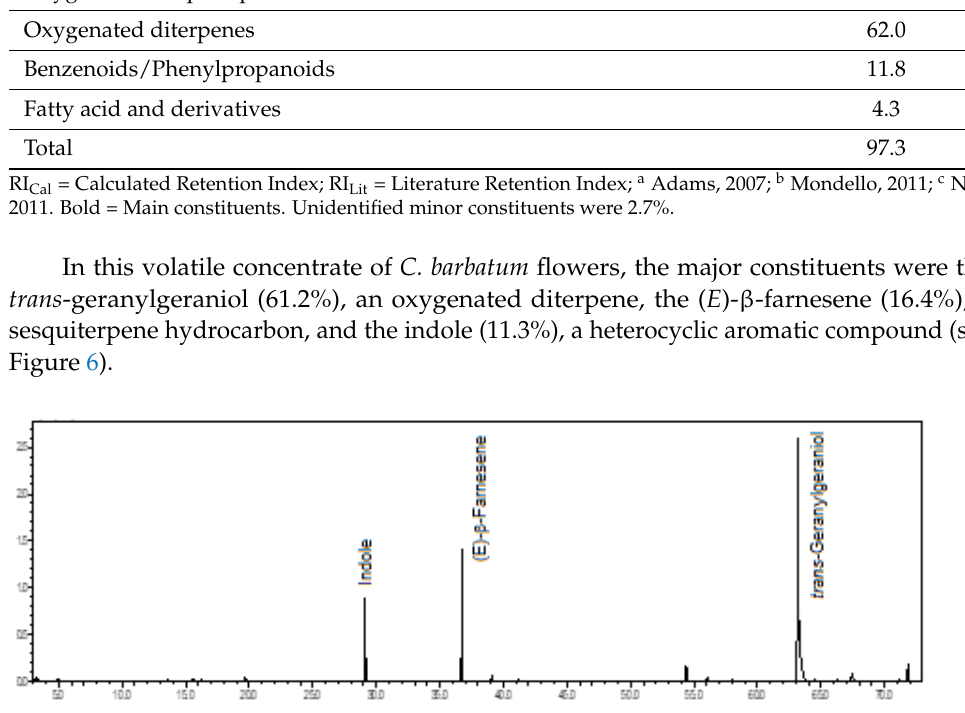
Figure 6. Ion-chromatogram of the Catasetum barbatum volatile concentrate.